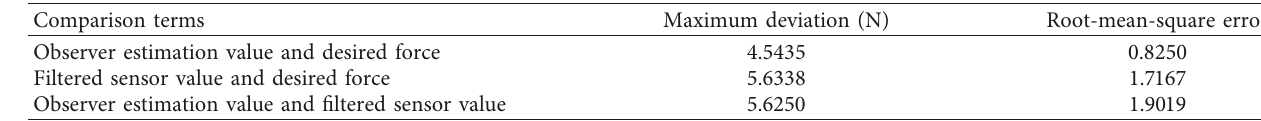
Figure 13: Contact force control experiment in the Z direction on a curved surface. (a) Without force controller. (b) Hybrid controller without compensation. (c) Hybrid controller with compensation. (d) Ordinary controller with compensation. Table 4: Comparison of Z -direction force control errors in Figure 13(b).